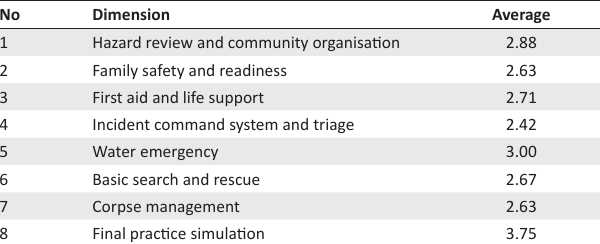
TABEL 2: The achievement of maximum scores in the aspect of skills based on the indicators of training materials.